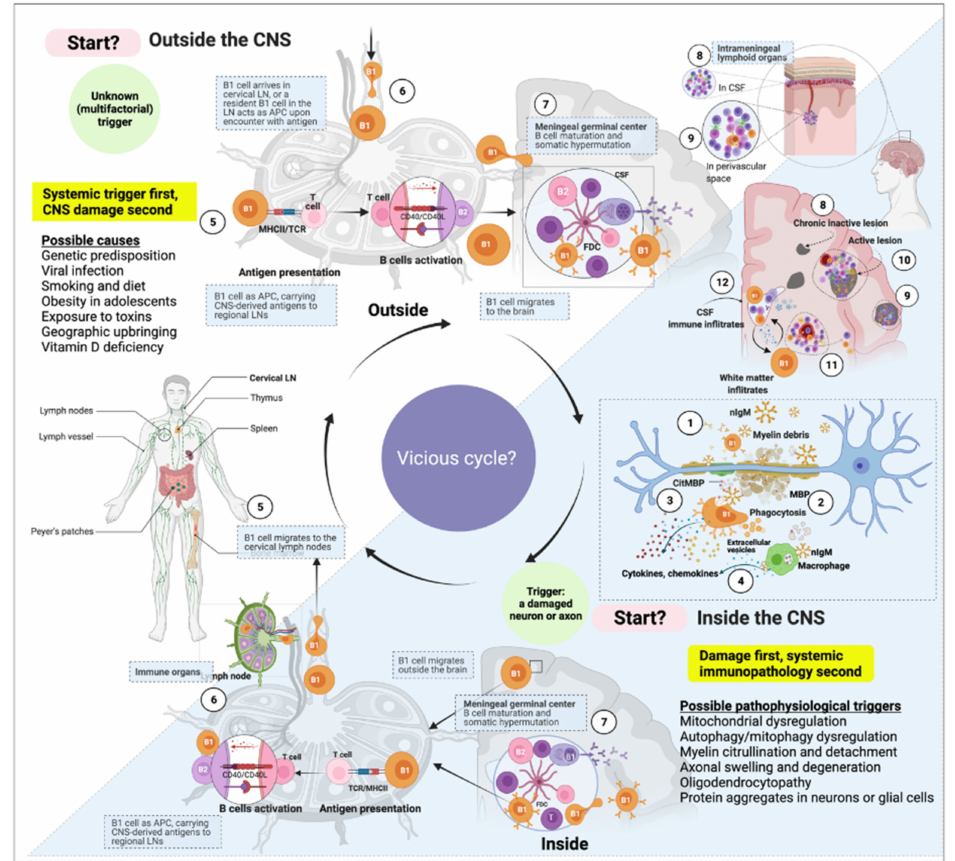
Figure 3. A cell’s journey according to the “inside-out” vs. “outside-in” paradigms of multiple sclerosis (MS). The immune response in MS might start at any point within the immune system or the central nervous system. The “inside-out” paradigm hints at an incidental instigation of